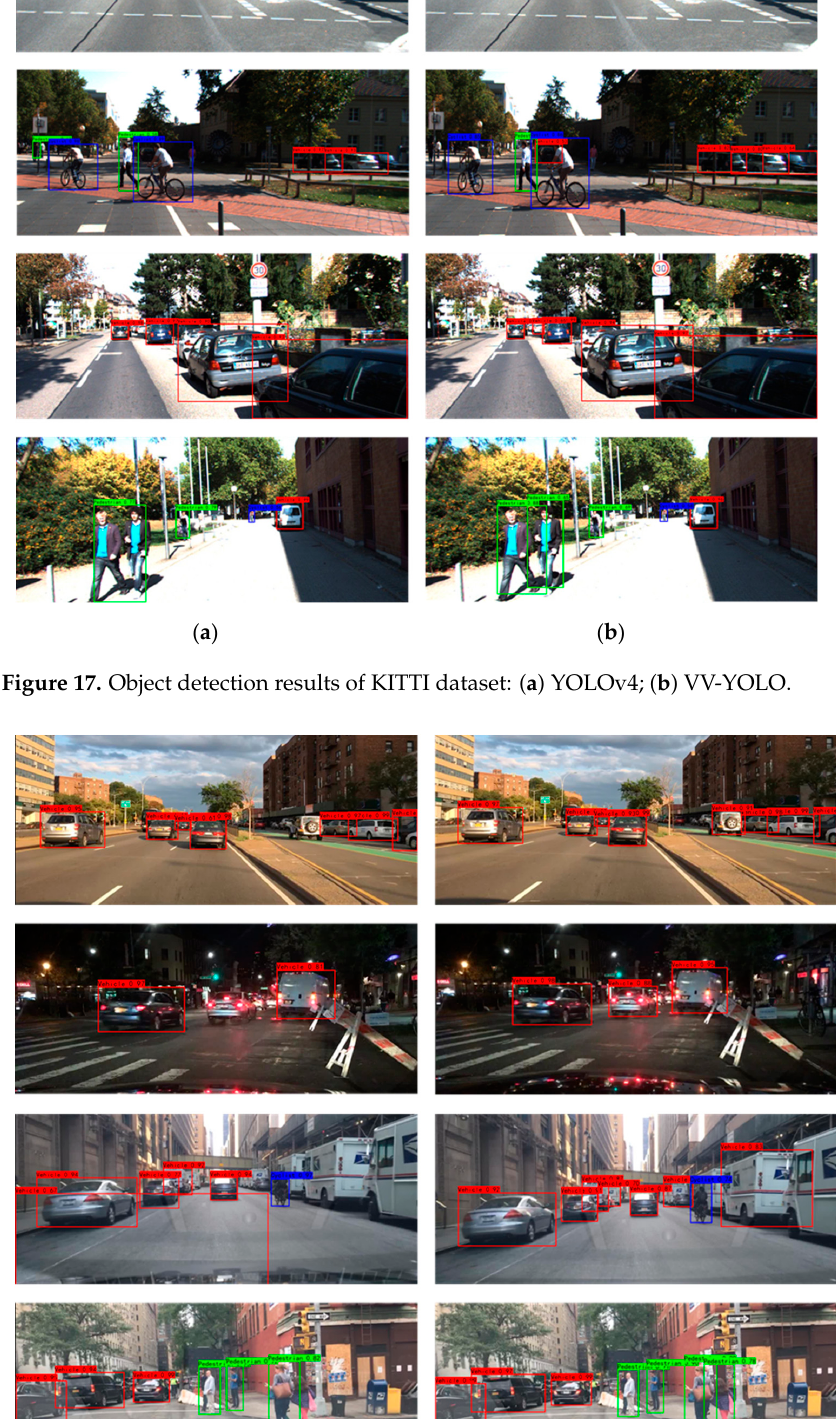
Figure 18. Object detection results of BDD100K dataset: ( a ) YOLOv4; ( b ) VV-YOLO.